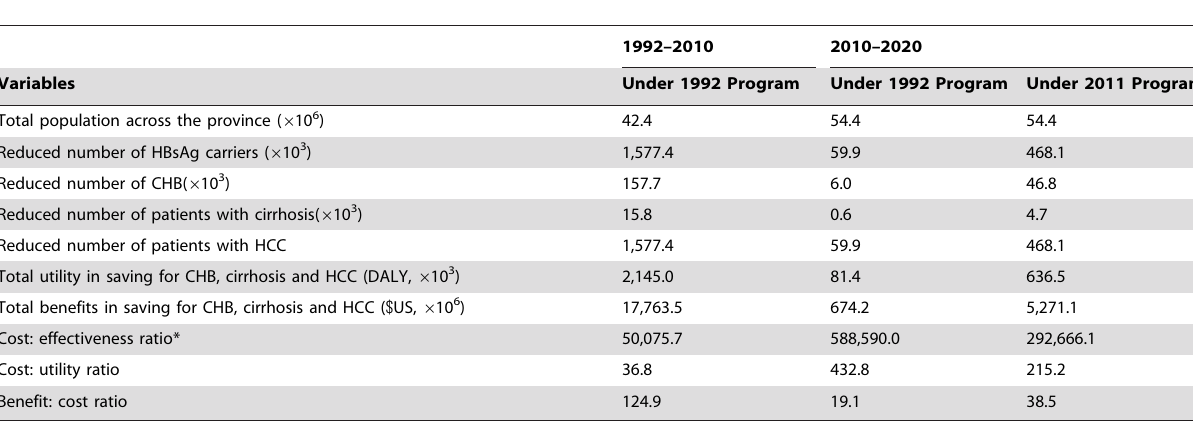
Table 3. Cost and benefit analysis for 1992 and 2011